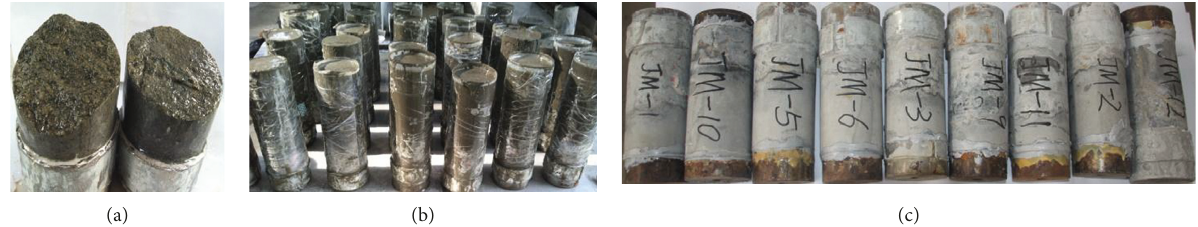
Figure 1: Fabrication process for rock-mortar interface specimen. (a) Natural fracture of rock; (b) casting of rock-mortar interface; (c) final rock-mortar interface specimen.